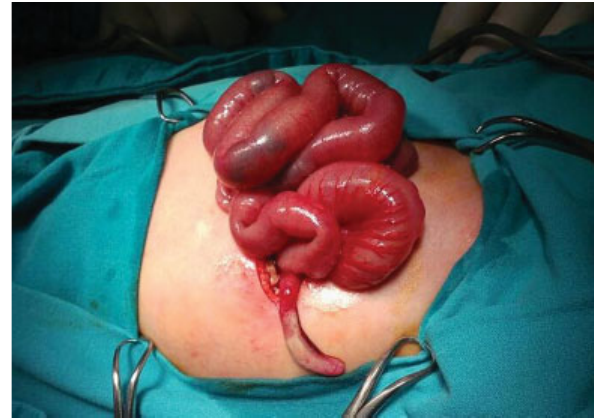
Fig. 3 Intraoperative fi nding showing in fl amed